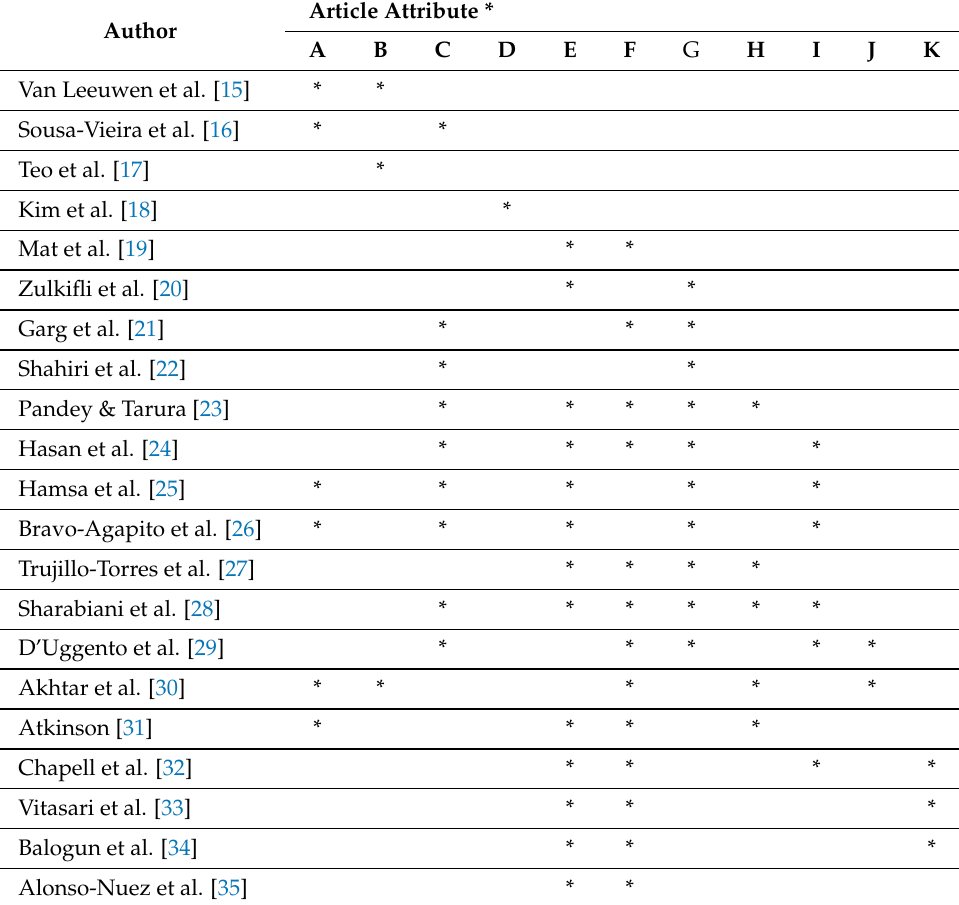
Table 1. Relation of article attributes, methods, and contribution to the field for Related